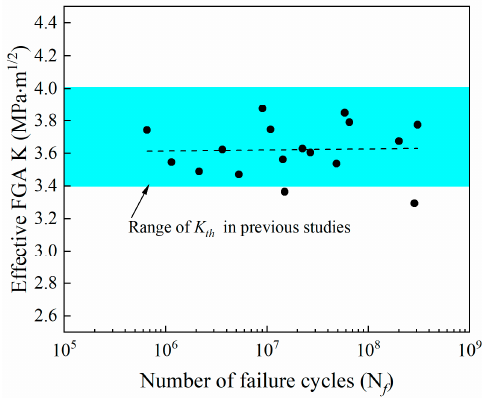
ff ective stress intensity factors of FGA (K